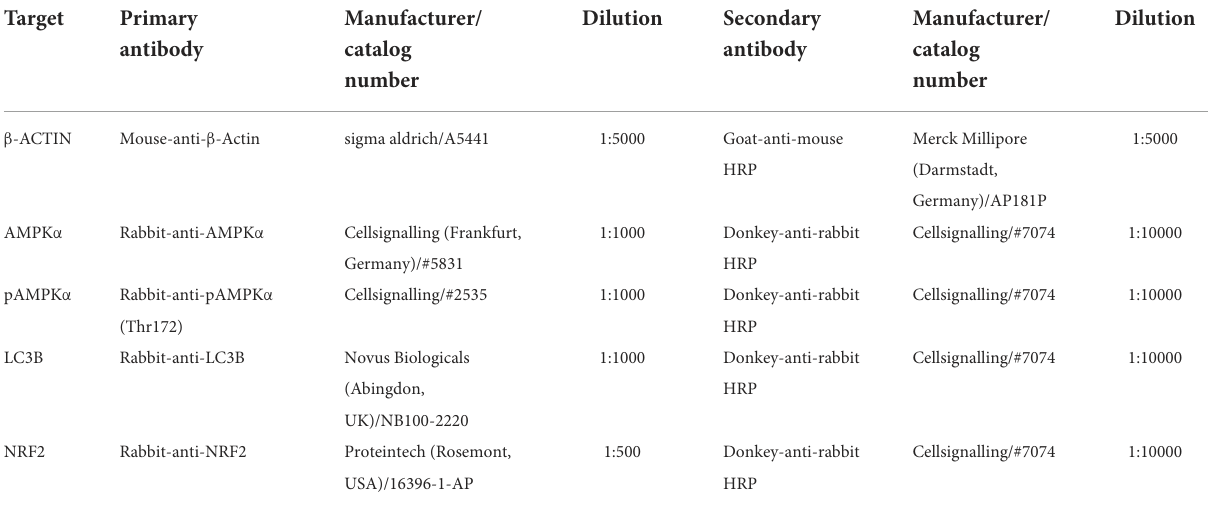
TABLE 2 Antibodies used for western